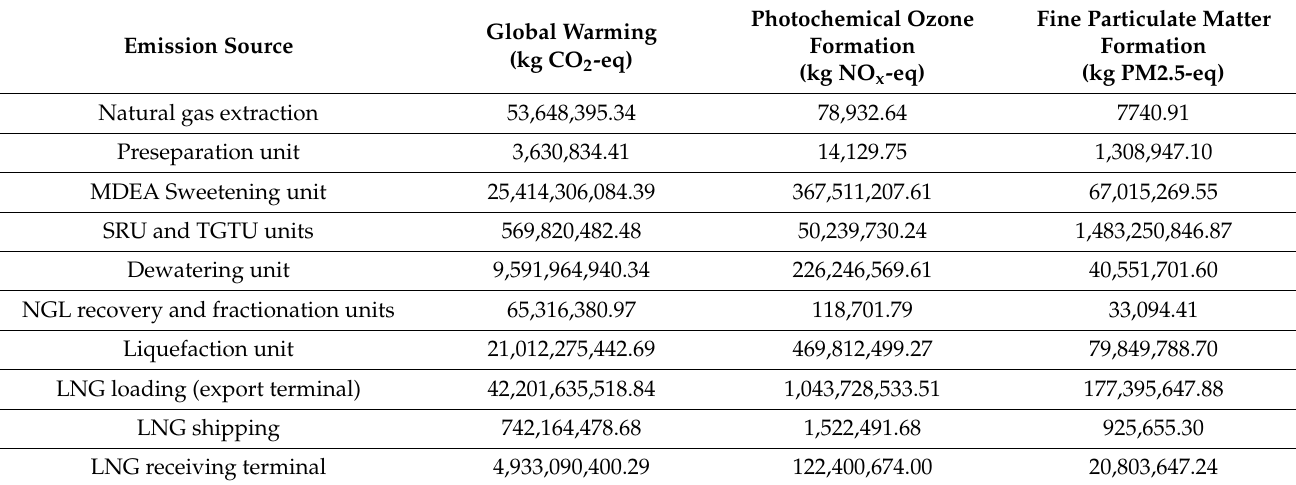
Figure 15. Heat map diagram for midpoint impact from several process units in LNG manufacturing and supply chain. Table 13. Midpoint impact results from several process units in LNG manufacturing and supply